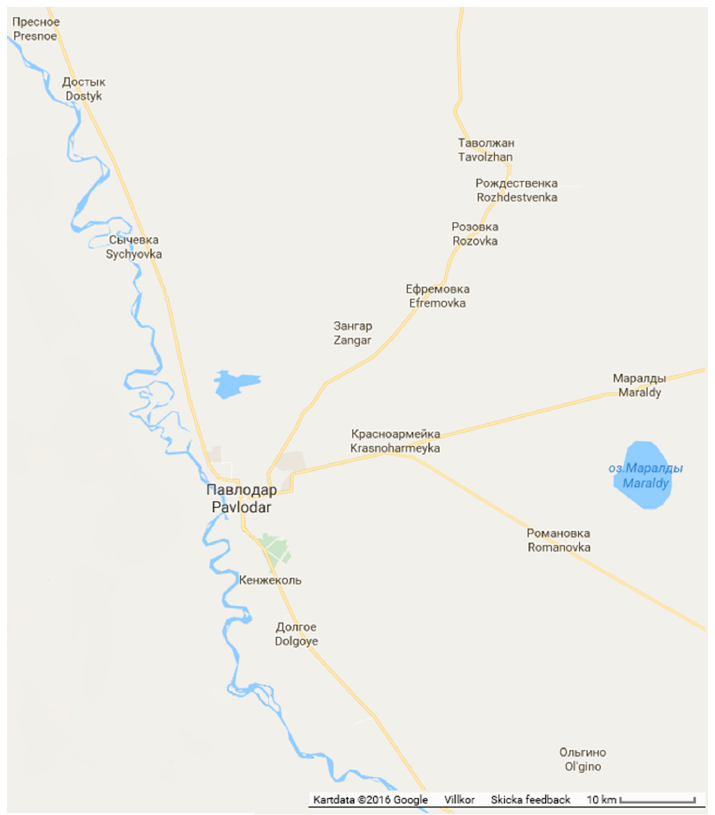
Figure 1. The experimental rural area around Pavlodar City in Kazakhstan.